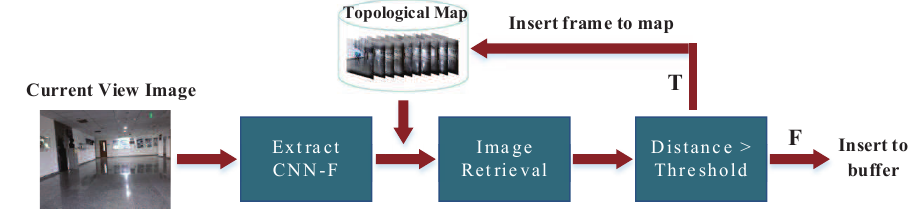
Figure 2. The flowchart of the topological mapping.